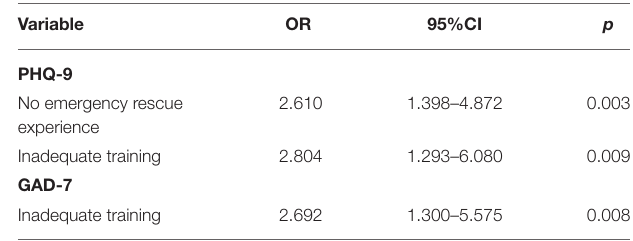
TABLE 2 | Subgroup physicians ( n = 82). TABLE 3 | Risk factors for depressive and anxiety